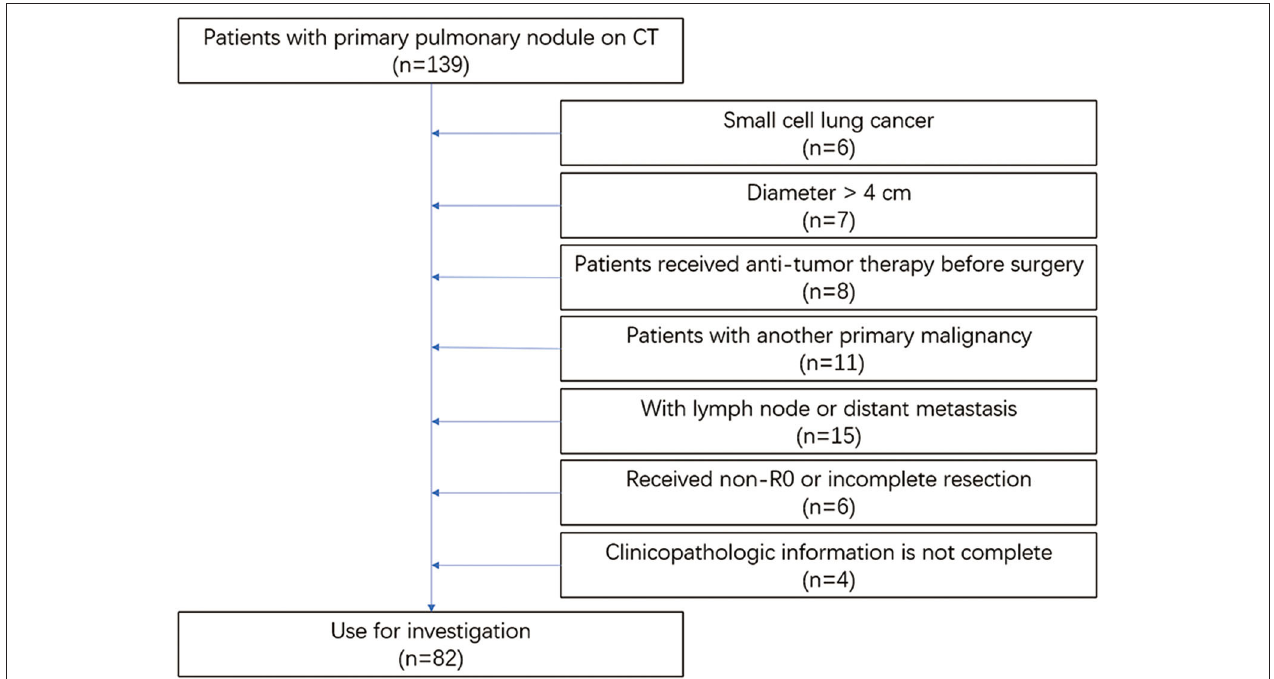
FIGURE 1 | Flowchart of this study. CT, computed tomography.